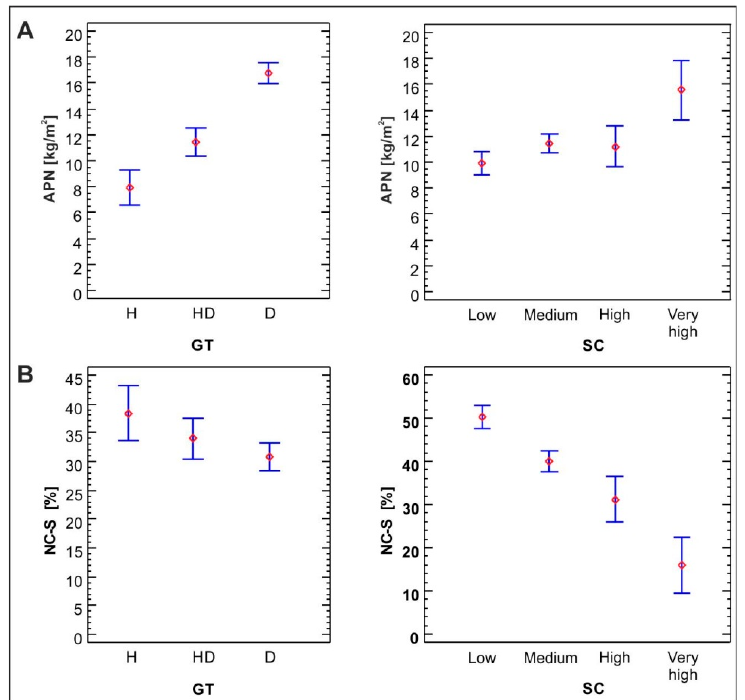
Figure 9. LSD (least significant difference) type confidence intervals of the nodule abundance (APN) ( A ) and seafloor nodule coverage ( B ) for different levels of factors: GT ( left ) and SC ( right ).